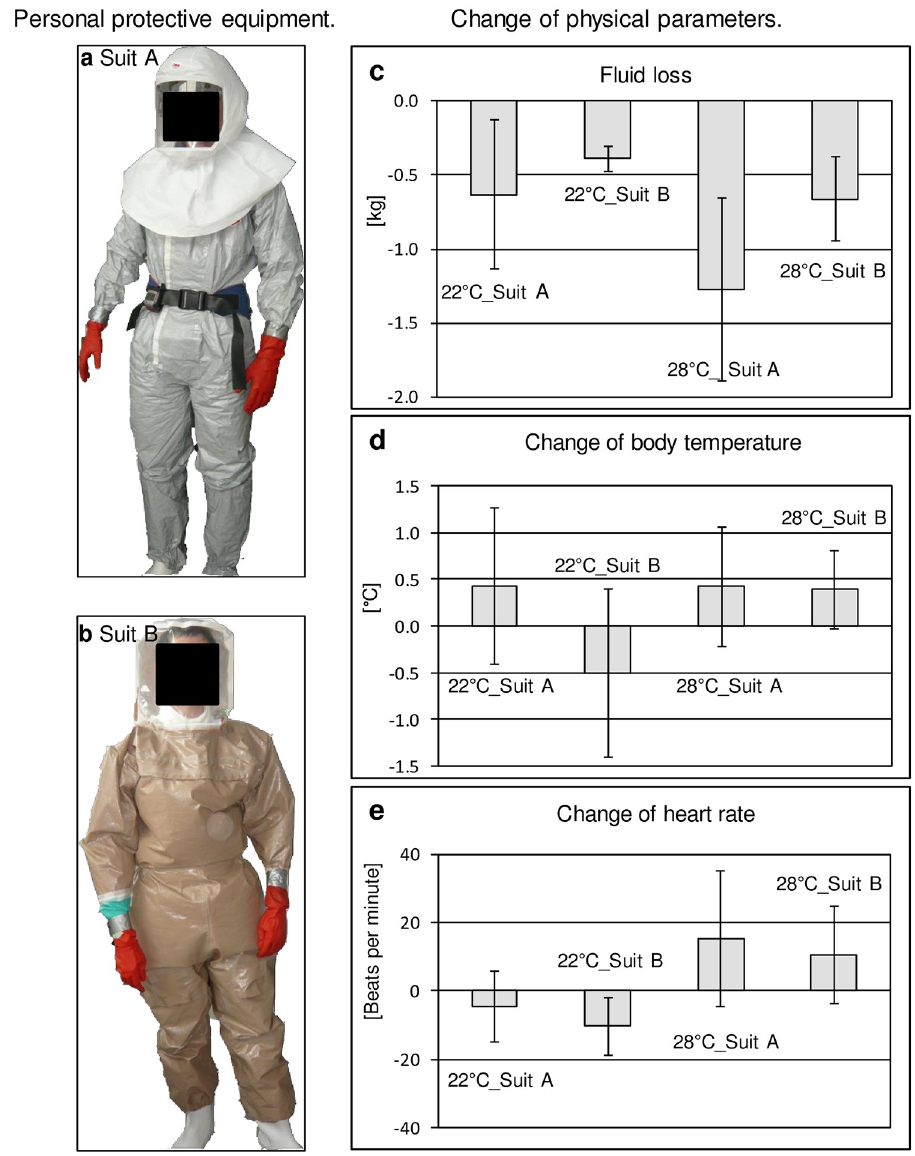
Fig 2. Personal protective equipment (suit A, suit B) and change of physical parameters. Suit A. (b) Suit B. (c) Fluid loss, (d) change of body temperature and (e) change of heart rate of subjects wearing different PPE were measured before the start and immediately after termination of the task series at 22˚C (6 hours) and 28˚C (4 hours). Mean values plus/minus standard deviation. (mean waiting time 14 days). Limiting factors for working conditions were rated after every series from 1 to 10 on the assessment sheet whereby ranking 10 was a reason for terminating the study. Heart rate (HR) was measured with a wireless heart rate monitor placed below the sternum directly on the skin (Garmin Forerunner 305) during the task series. HR data before and after the task series was used for statistical analysis. Body temperature was assessed by tympanic infrared temperature measurement. Body weight was measured without PPE and undergarment at the beginning and after the last test (measurement accuracy 0.1kg) for cal- culating dehydration.